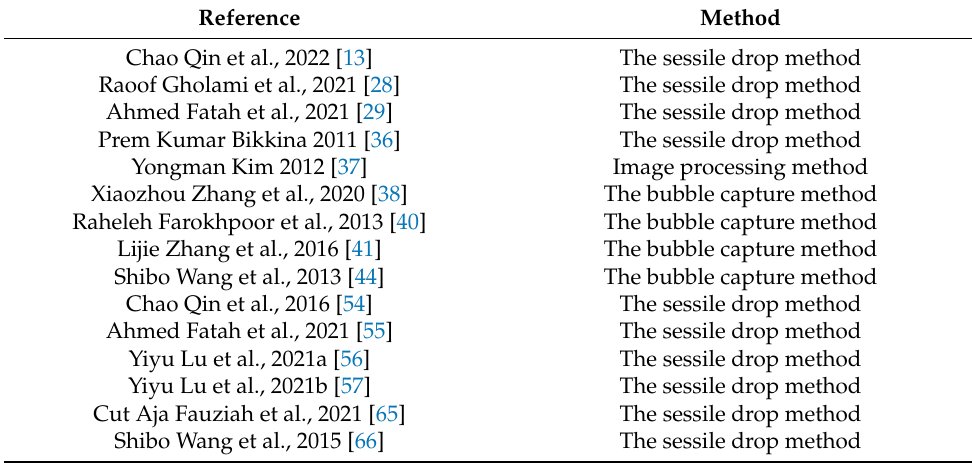
Table A1. Contact angle